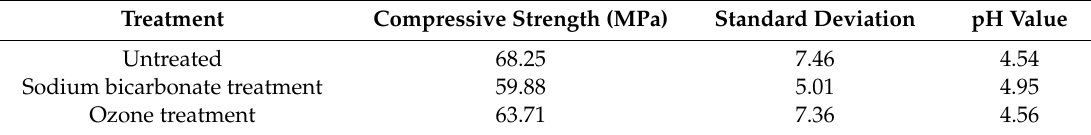
Table 5. The compressive strength and pH value of RP before and after treatment.